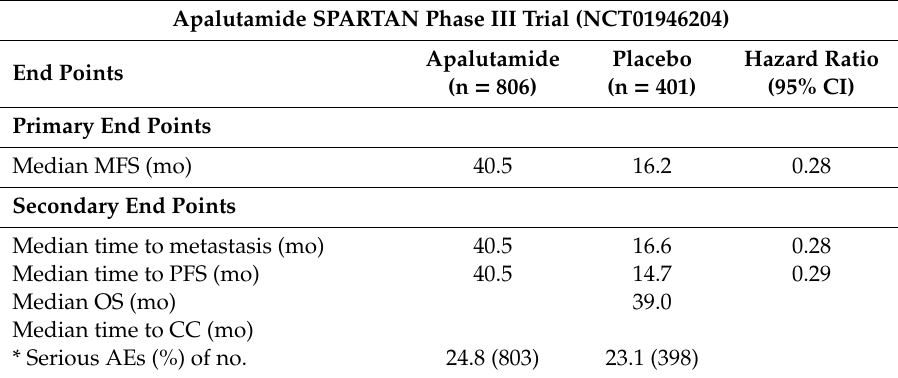
Table 7. Major therapeutic benefits brought by apalutamide based on